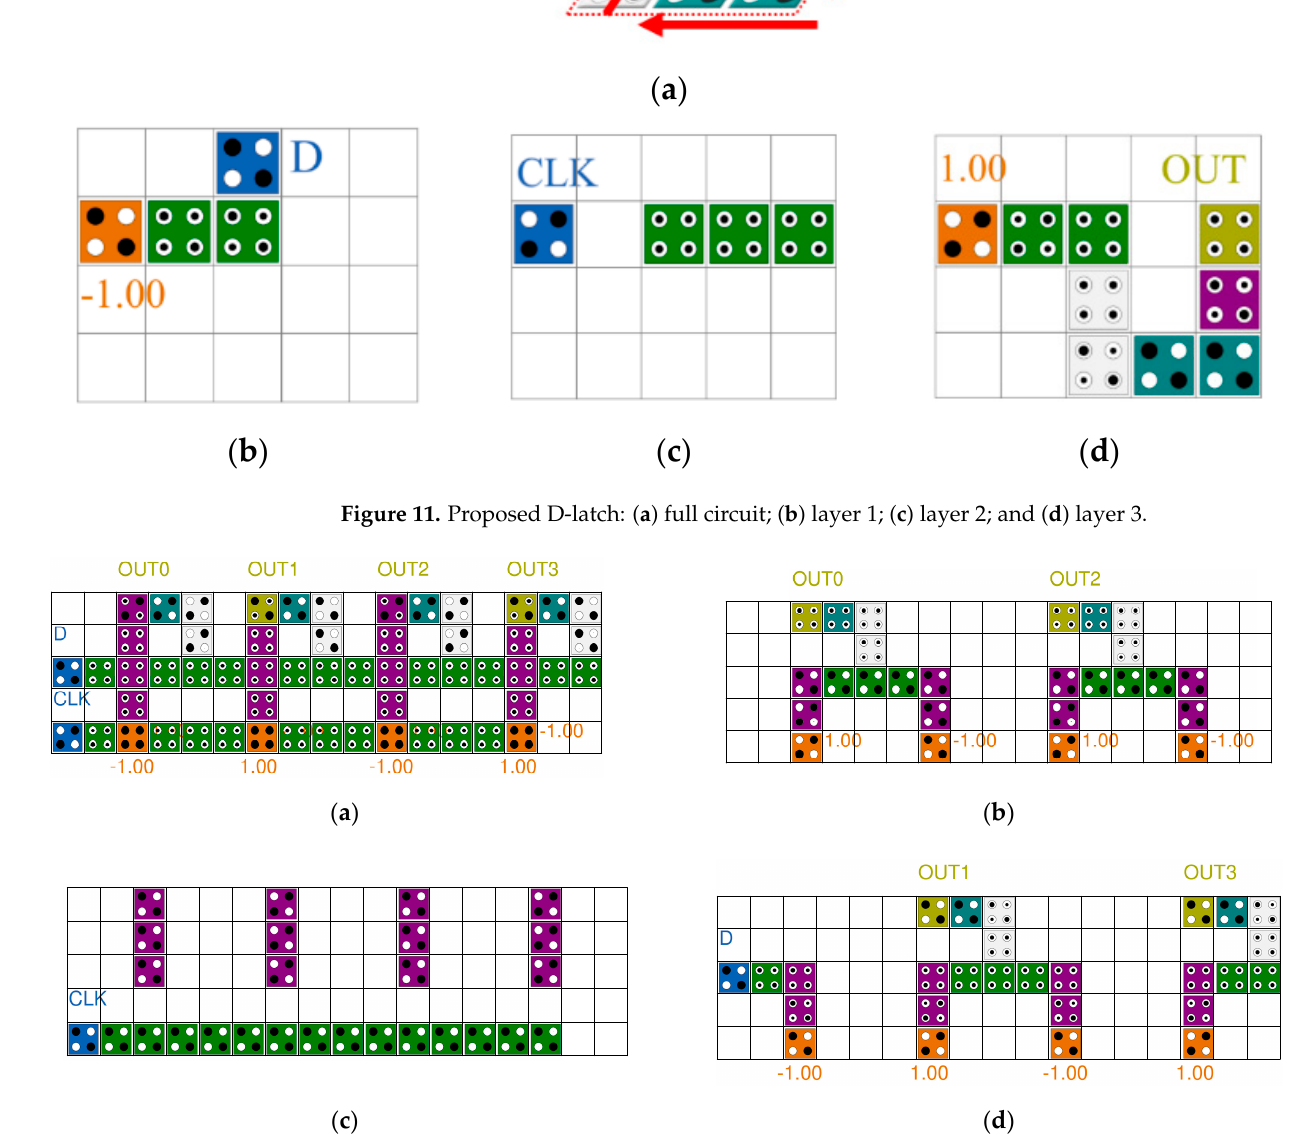
Figure 11. Proposed D-latch: ( a ) full circuit; ( b ) layer 1; ( c ) layer 2; and ( d ) layer 3.